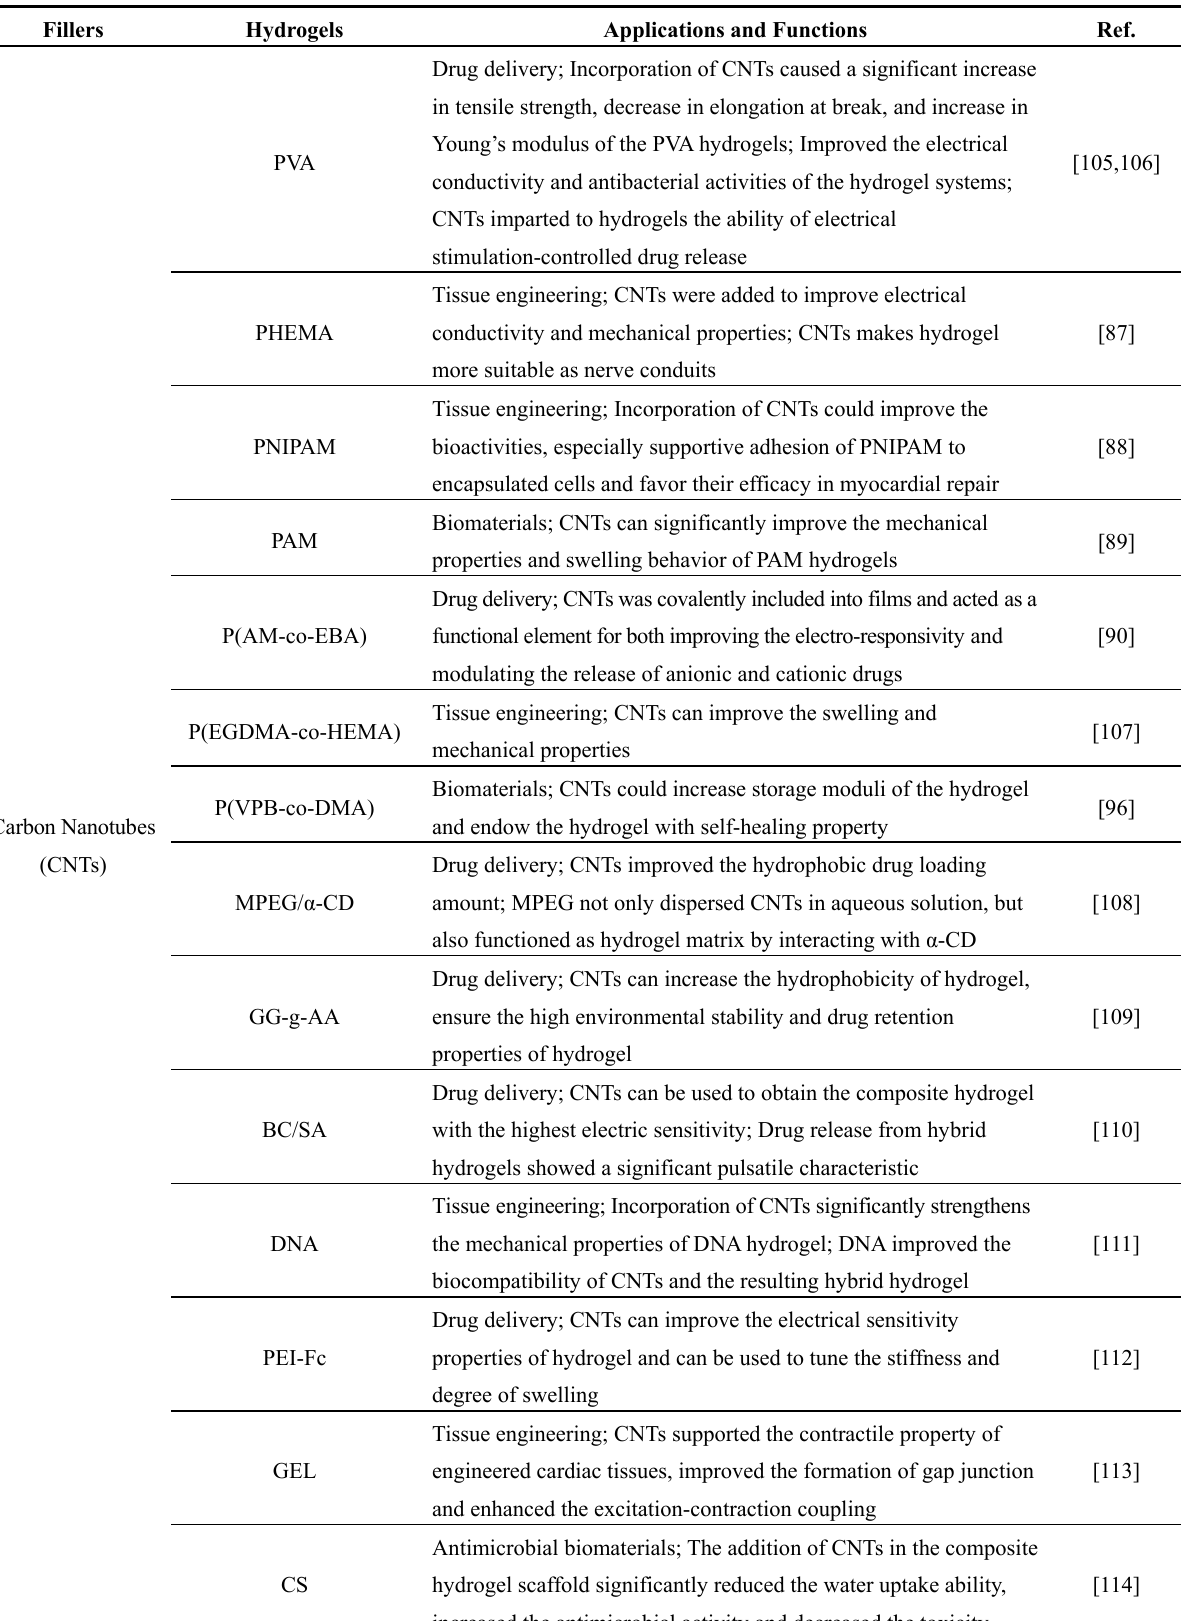
Table 1. Summary of the most recent advances of nanocomposite hydrogels from hydrogels and carbon-based NPs for biomedical